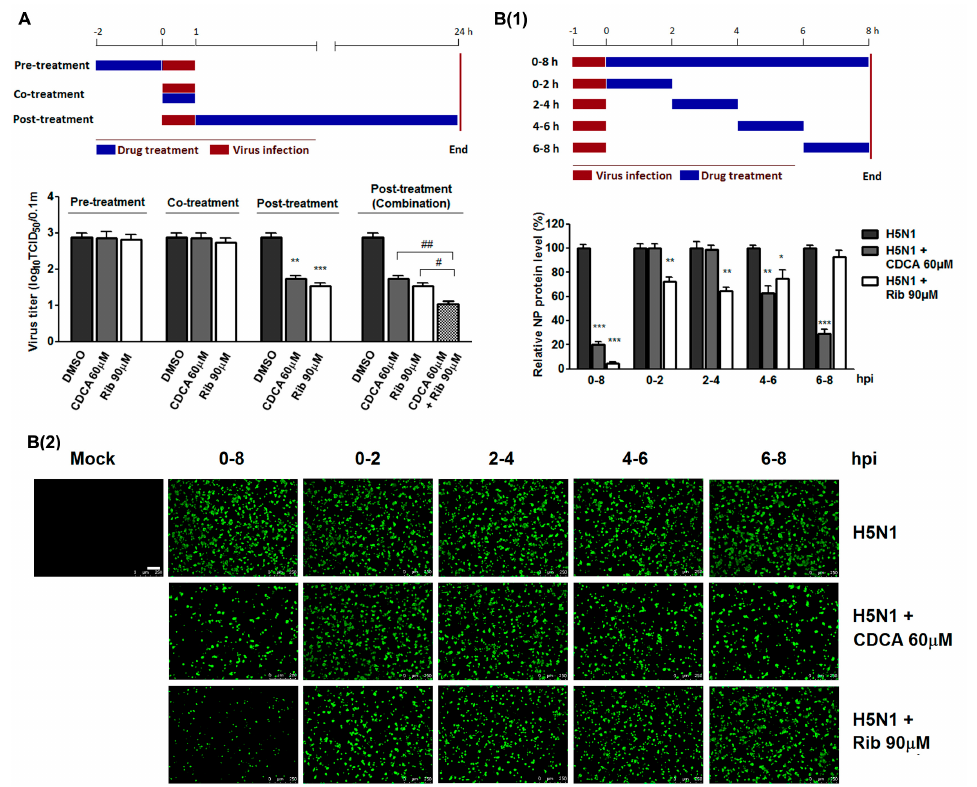
Figure 5. CDCA inhibited H5N1 replication by targeting the later stage of the virus lifecycle. ( A ) Time course inhibition assay. A549 cells grown in 24-well plates were treated with CDCA or ribavirin or their combination for 2 h prior to virus infection (pretreatment), for 1 h during the viral adsorption period (cotreatment), or for 24 h after 1 h virus infection and removal (post-treatment). For three treatment models, 0.1 MOI of H5N1 was used for infecting cells for 1 h. At 24 hpi, supernatants were collected for determining virus titer using the end point dilution assay. Upper panel: the experimental design. Lower panel: virus titers from three independent experiments. ( B ) Time-of-addition assay. A549 cells grown in 24-well plates were infected with 1.0 MOI of H5N1 for 1 h. After two washes with PBS, 60 µ M of CDCA or ribavirin was added at the indicated times and removed after 2 h or 8 h. After each incubation period, the cells were incubated with fresh medium until 8 hpi. The cells were then subjected to viral NP protein analysis using IFA. The experimental design was shown in the upper panel ( B1 ). Results shown in the lower panel ( B1 ) are normalized NP protein levels based on the fluorescence optical densities (OD) of the images from three independent experiments. Software Image J was used to digitize image OD; results from CDCA or ribavirin treated samples were compared to those from corresponding DMSO-treated control groups (set as 100%). Representative IFA images of the three independent experiments are shown in the B2 panel. Scale bar: 125 µ m. Statistical significances are denoted by * p < 0.05, ** p < 0.01, and *** p < 0.001 compared to DMSO control, and # p < 0.05 and ## p < 0.01 between indicated